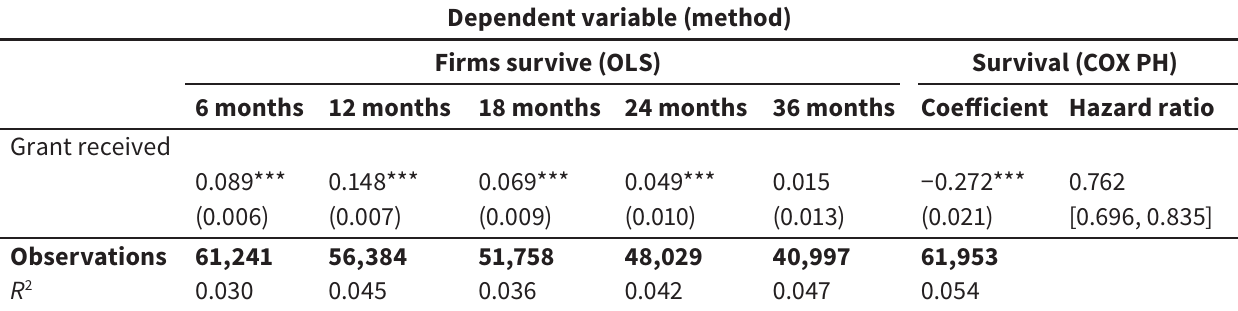
OLS and Cox proportional hazard estimates of firm survival (unlimited liability